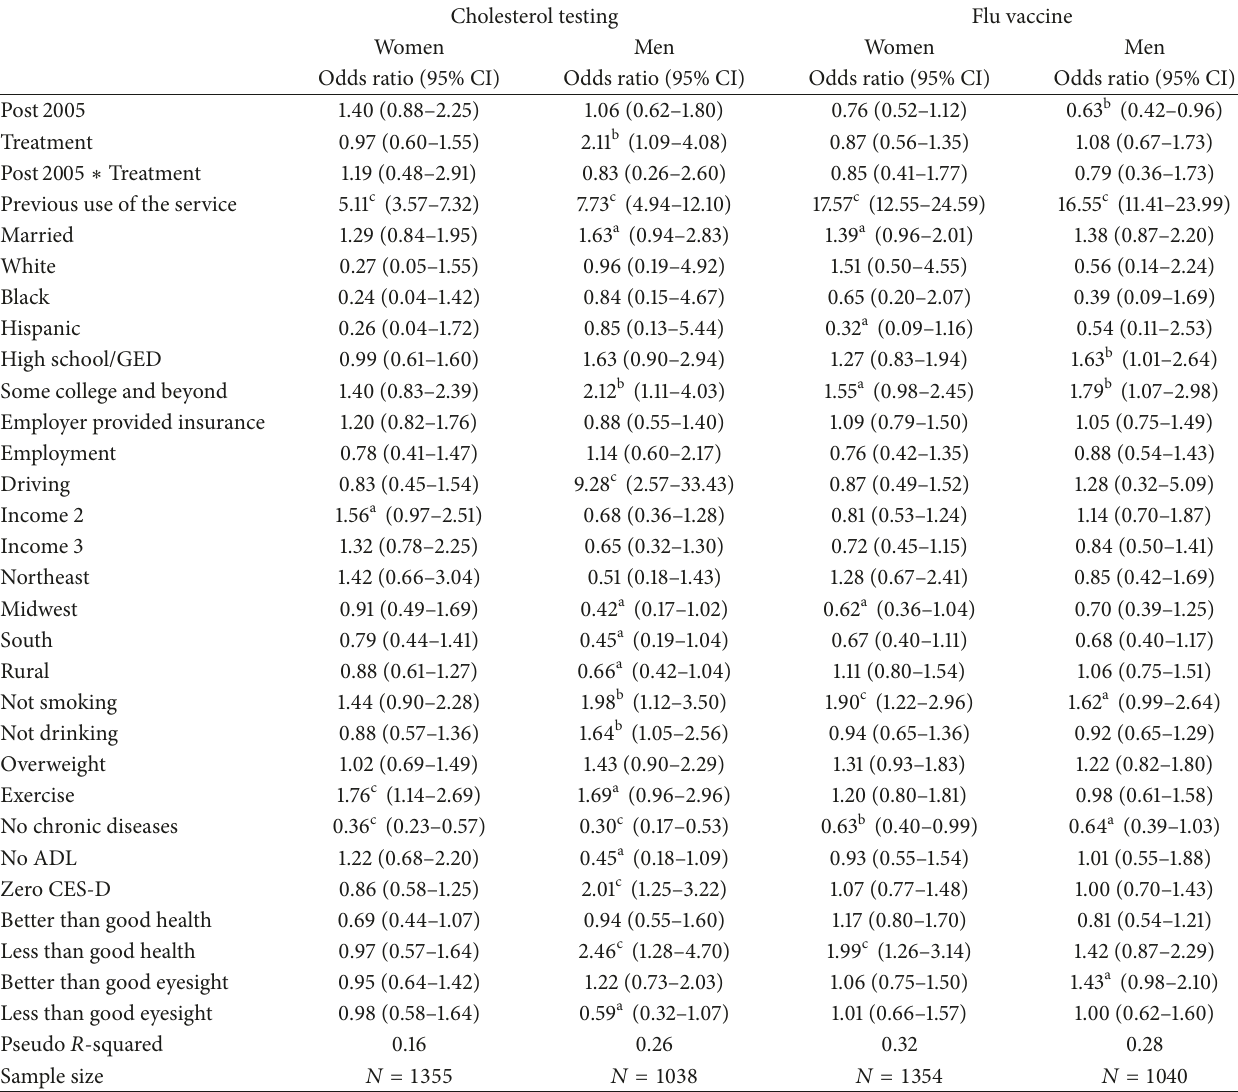
Table 3: Odds ratios derived from multivariate logit models for the receipt of cholesterol testing and flu vaccine (Health and Retirement Study data,